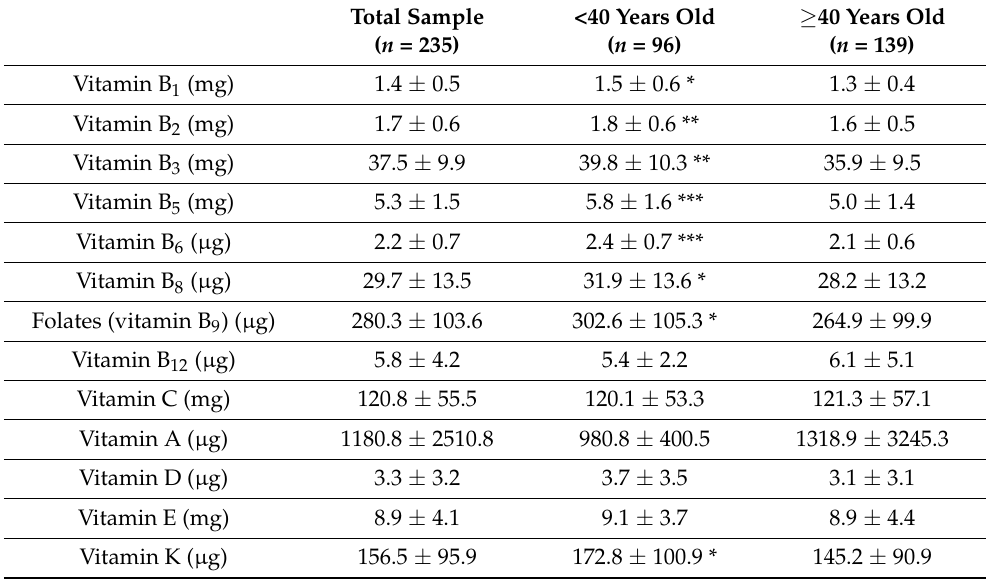
Table 4. Daily vitamin intake of the total sample and sorted by age groups.